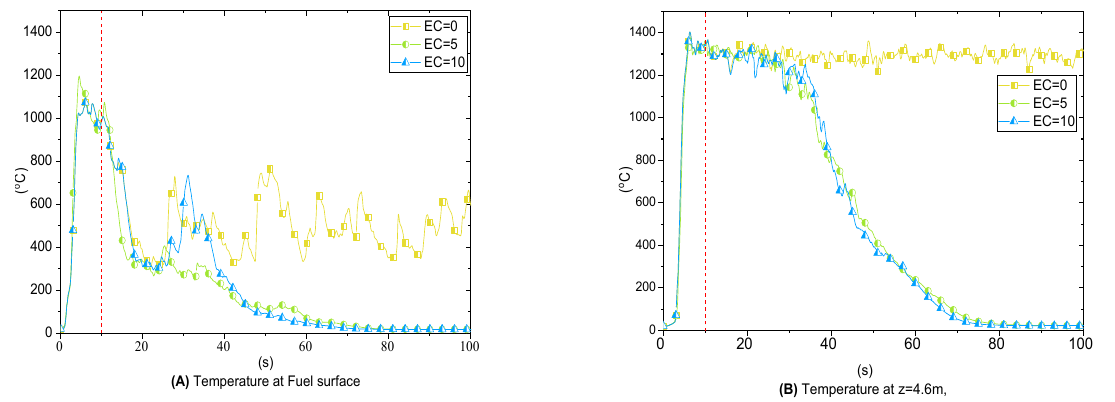
(s) Figure 3. Mesh sensitivity analysis of fire suppression by water. The mesh sensitivity based on the cell size can also be decreased depending on the user or at a point where the results are non-variable. However, this process of decreasing the cell size into an overly sensitive setting could also lead to the high computational time. Not only this, but it could result in a number of non-uniform outputs. During this process, the start time of the nozzle was set to 10 s, which is illustrated with the red dotted line shown in Figure 3. 3.2. Flame Extinction The flame extinction during the fire suppression by water droplets can also be varied with another important parameter, which is the extinction coefficient. The coefficient was first implemented by Yu et al., which was further modified by Hammins and McGrattan for its application